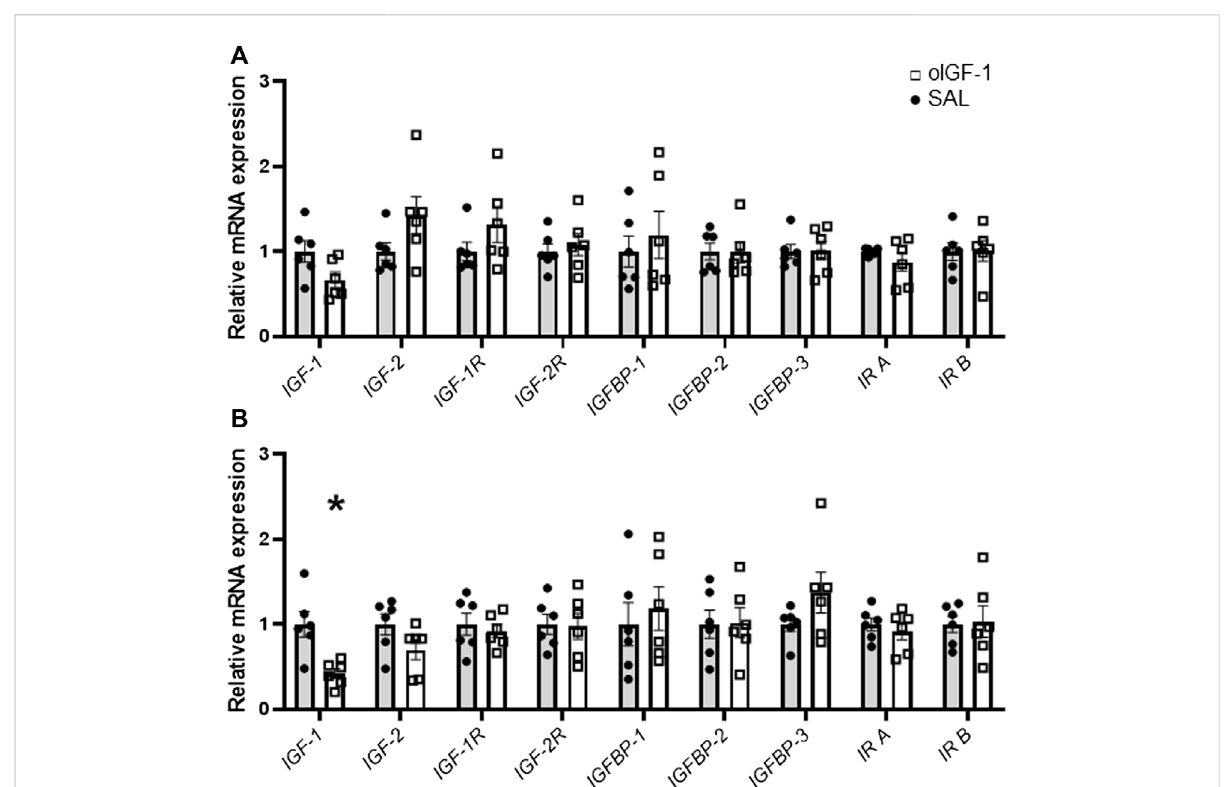
FIGURE 7 mRNA expression of IGF related targets in biceps femoris muscle and liver after chronic recombinant ovine IGF-1 (oIGF-1) infusion. mRNA expression of IGF related targets in (A) muscle and (B) liver from fetal sheep that received a 1-week infusion of either oIGF-1 (n = 6, open squares) or saline (SAL, n = 6, closed circles). Individual data points and means ± SEM are shown. *Indicates signi fi cantly different ( p ≤ 0.05) between SAL and oIGF-1 as determined by paired t